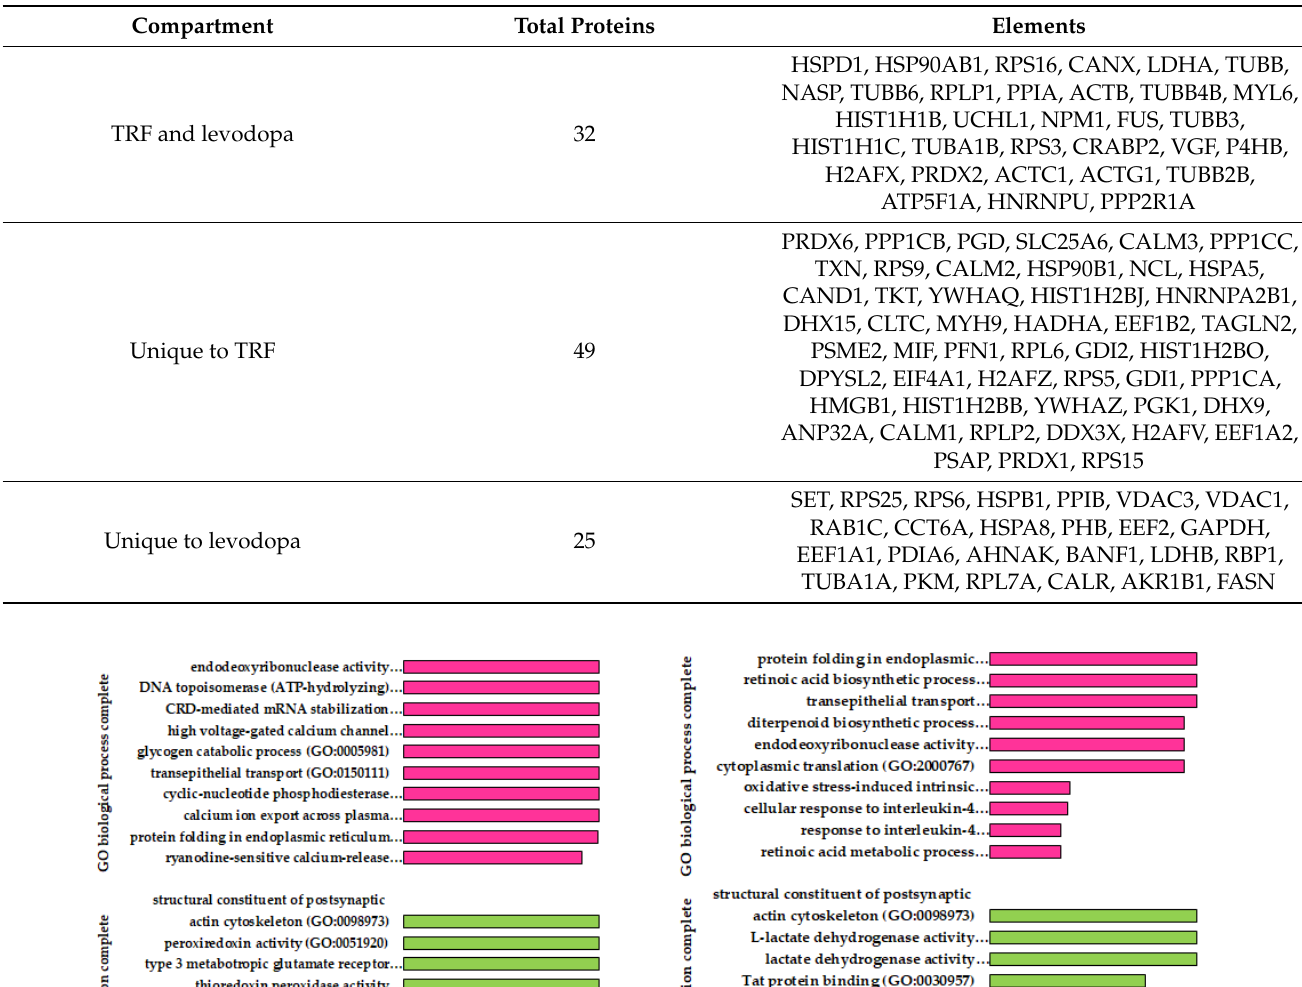
Table 3. List of unique and common proteins between the levodopa and TRF treatment on diff-neural cell.